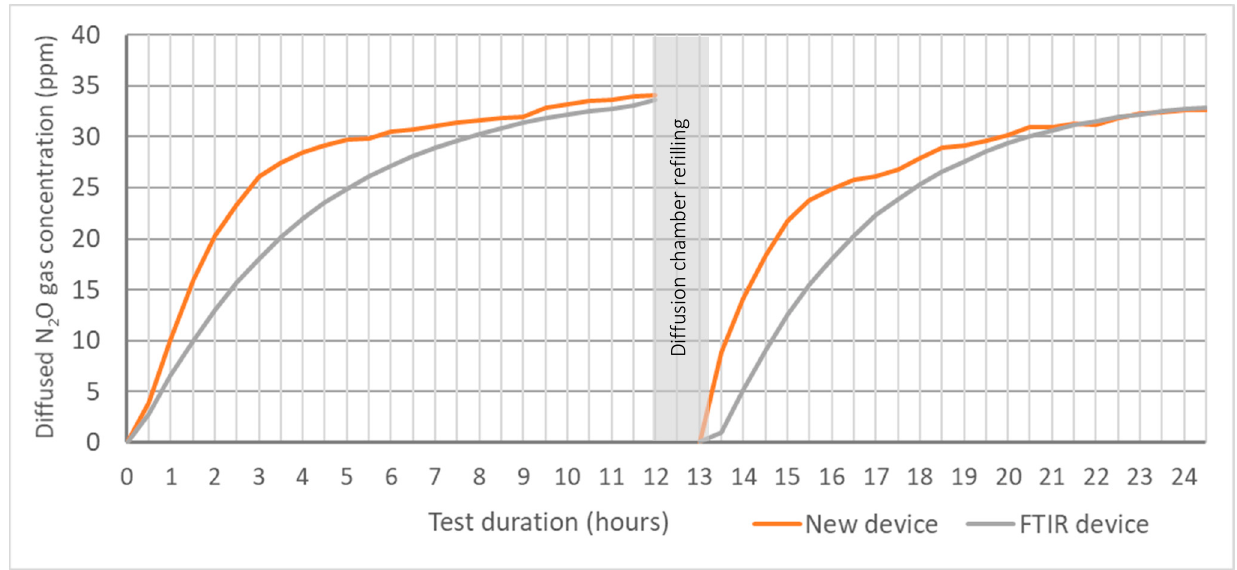
Figure 9. Diffusion rate of N 2 O gas into the sampling cell.